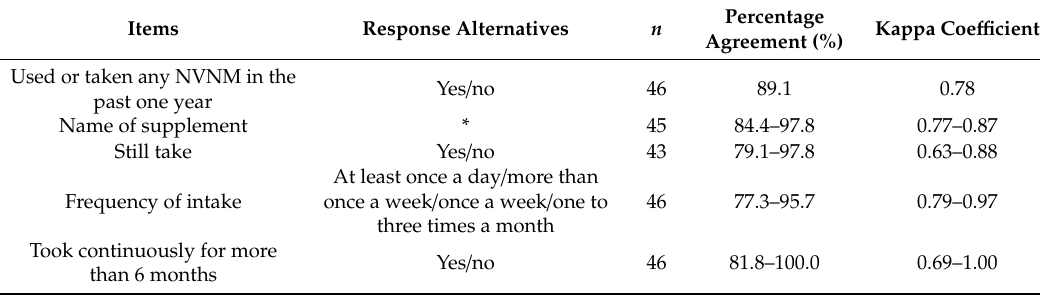
Table 4. Cohen’skappa( k )coefficientfor thenon-vitamin /